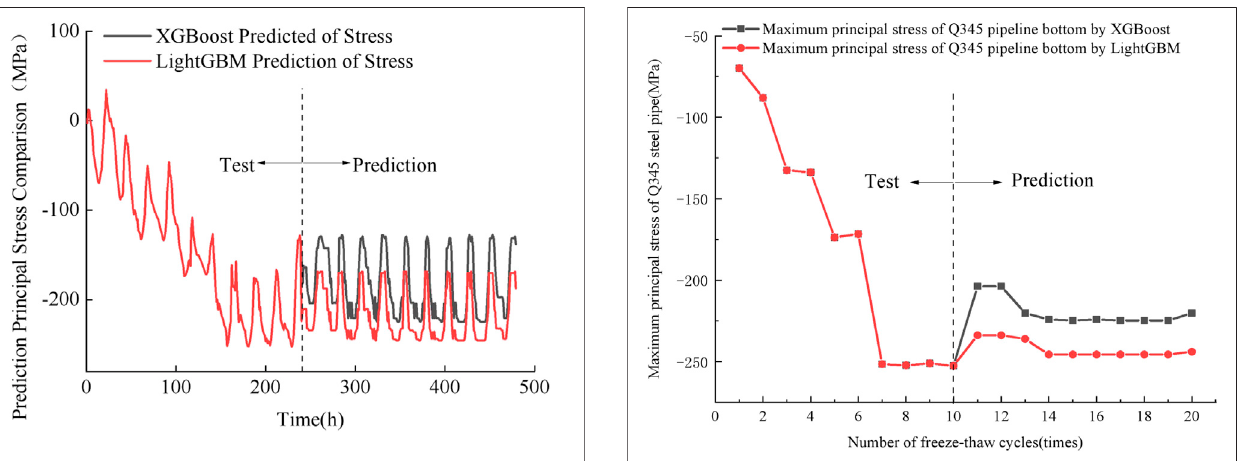
FIGURE 11 | Prediction of the principal stress evolution at the pipeline bottom via XGBoost and LightGBM. FIGURE 12 | The maximum principal stress evolution at the pipeline bottom with the number of freeze-thaw